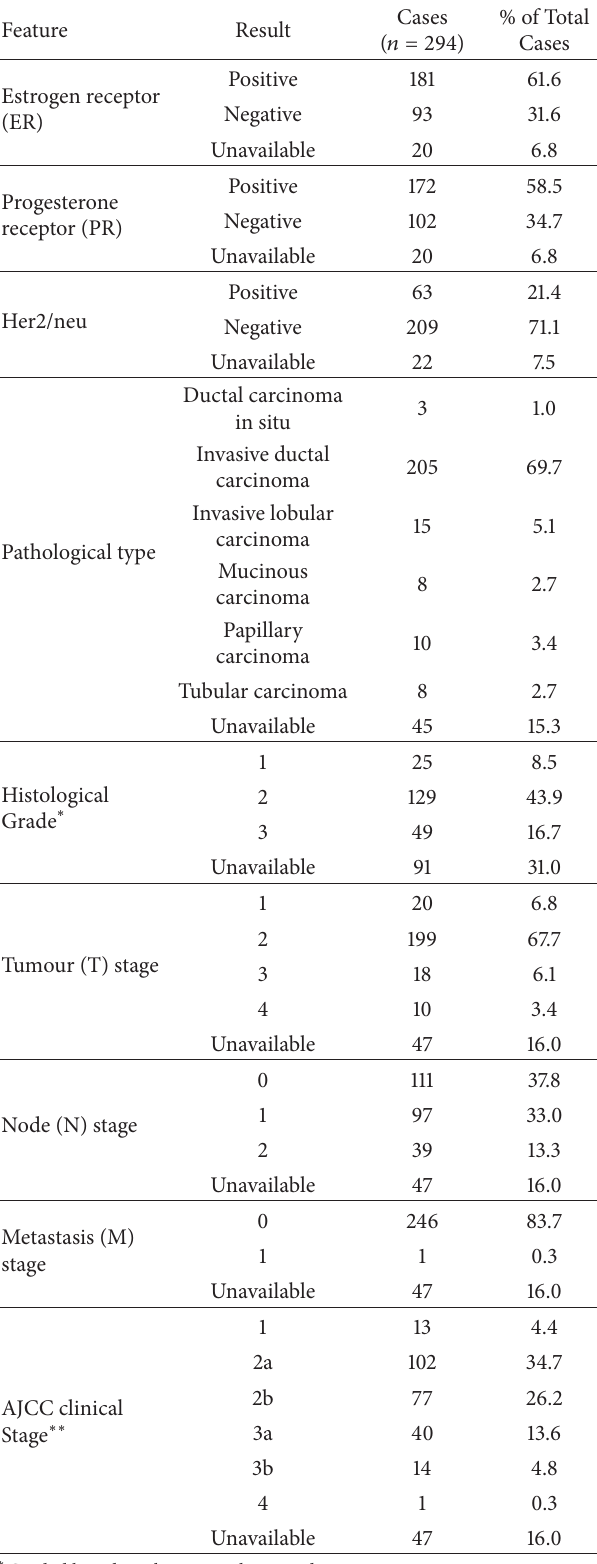
∗ Graded based on the Nottingham grading system. ∗∗ refers to American Joint Committee on Cancer (AJCC) staging system for breast